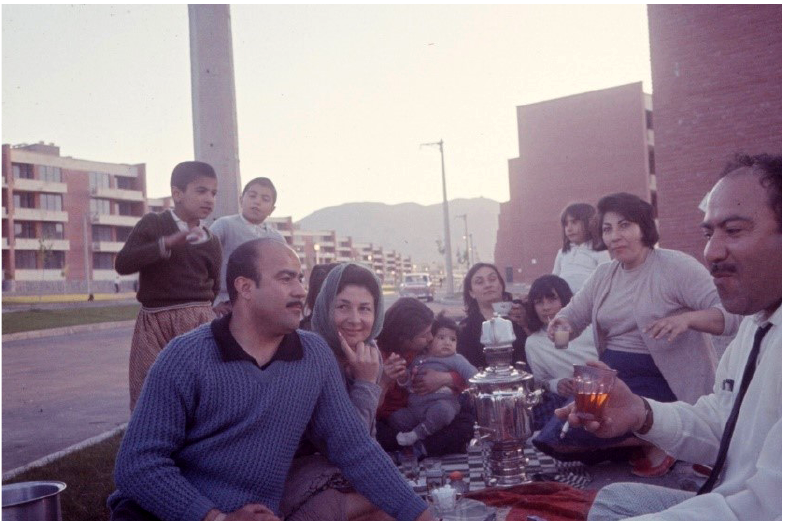
Figure 11. Kuy-e Kan’s residents using the side-walks as a collective space for gathering and eating, 1964. Source: LIFE